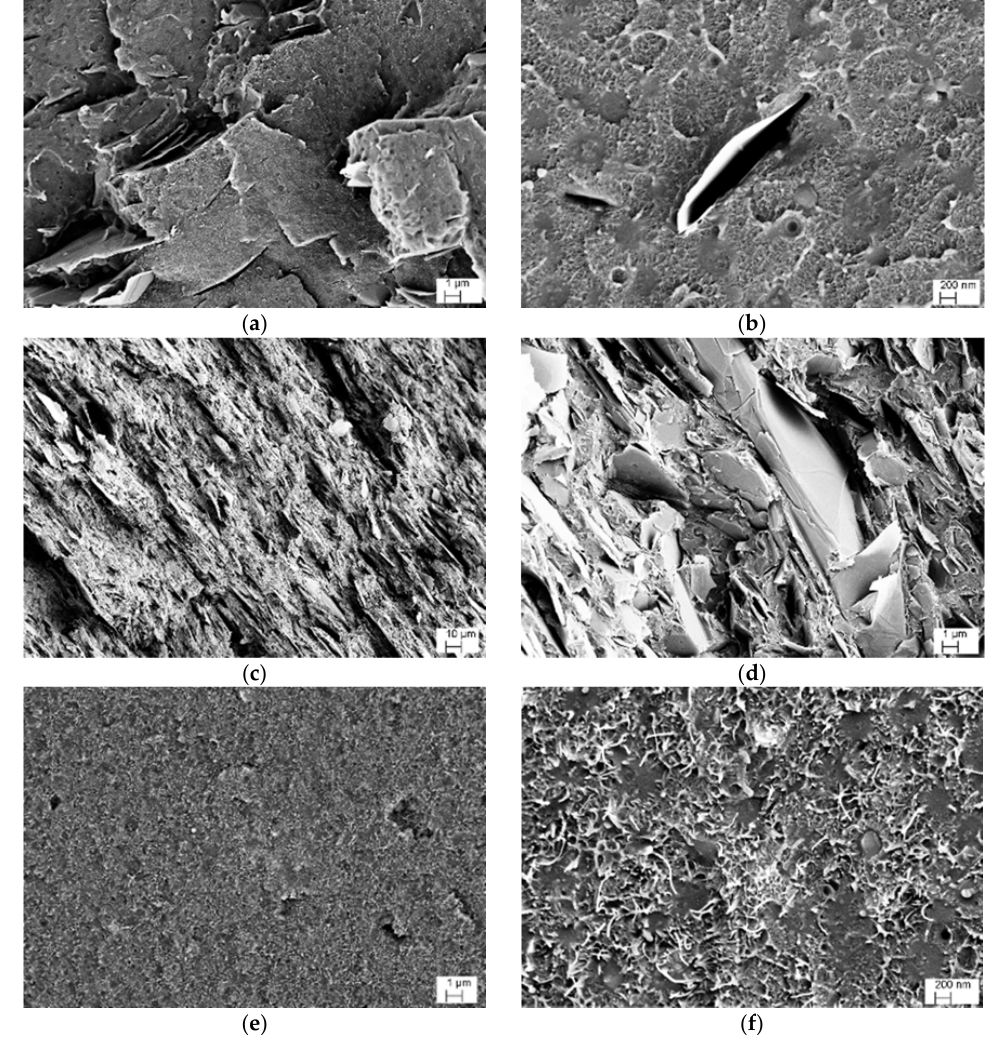
Figure 2. SEM micrographs of the samples of GNP ‐ 6 ( a , b ), GNP ‐ 30 ( c , d ) and CNT ‐ 6 ( e , f ).